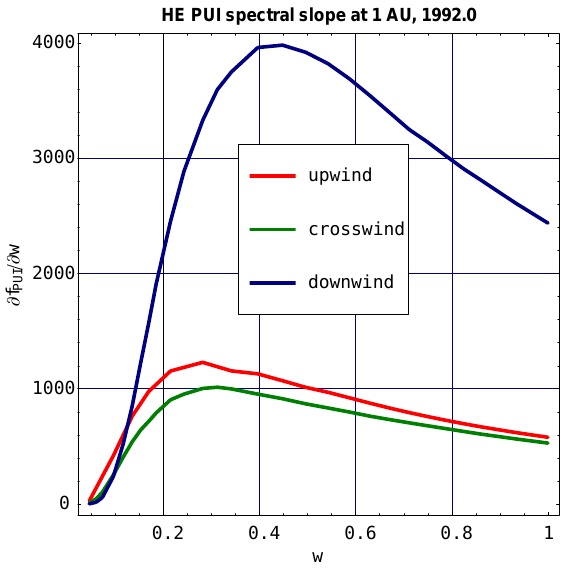
Fig. 18. As Fig. 17 but for solar maximum epoch